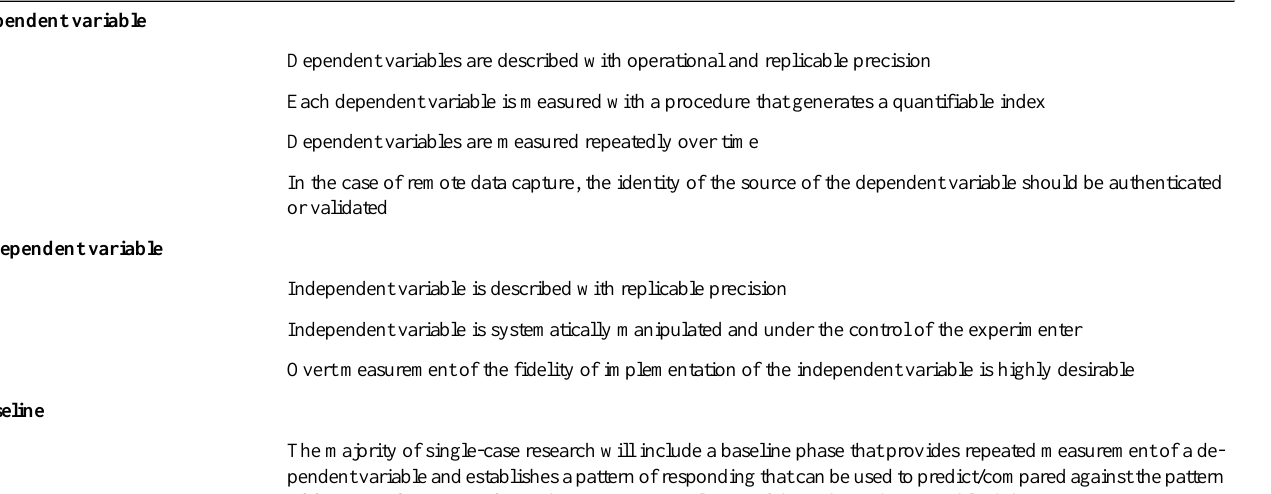
Table 2. Quality indicators for single-case